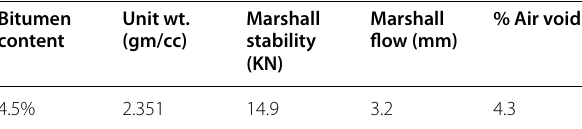
Table 5 Marshall test parameters for final design mix for 50-mm thick DBM layer Bitumen Unit wt. content